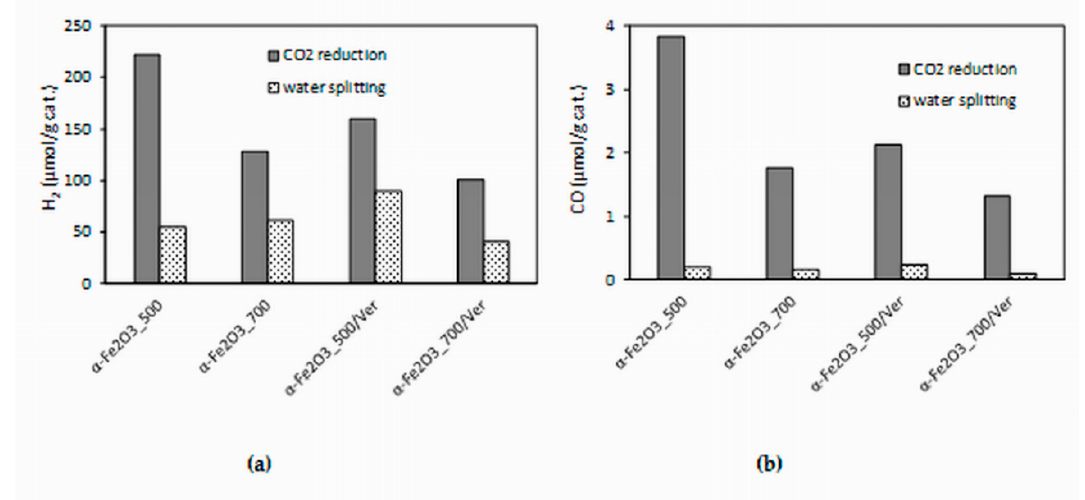
Figure 10. Dependence of yields of: ( a ) H 2 and ( b ) CO (after 14 h of irradiation) during CO 2 photocatalytic reduction and water splitting in the presence of investigated photocatalysts.